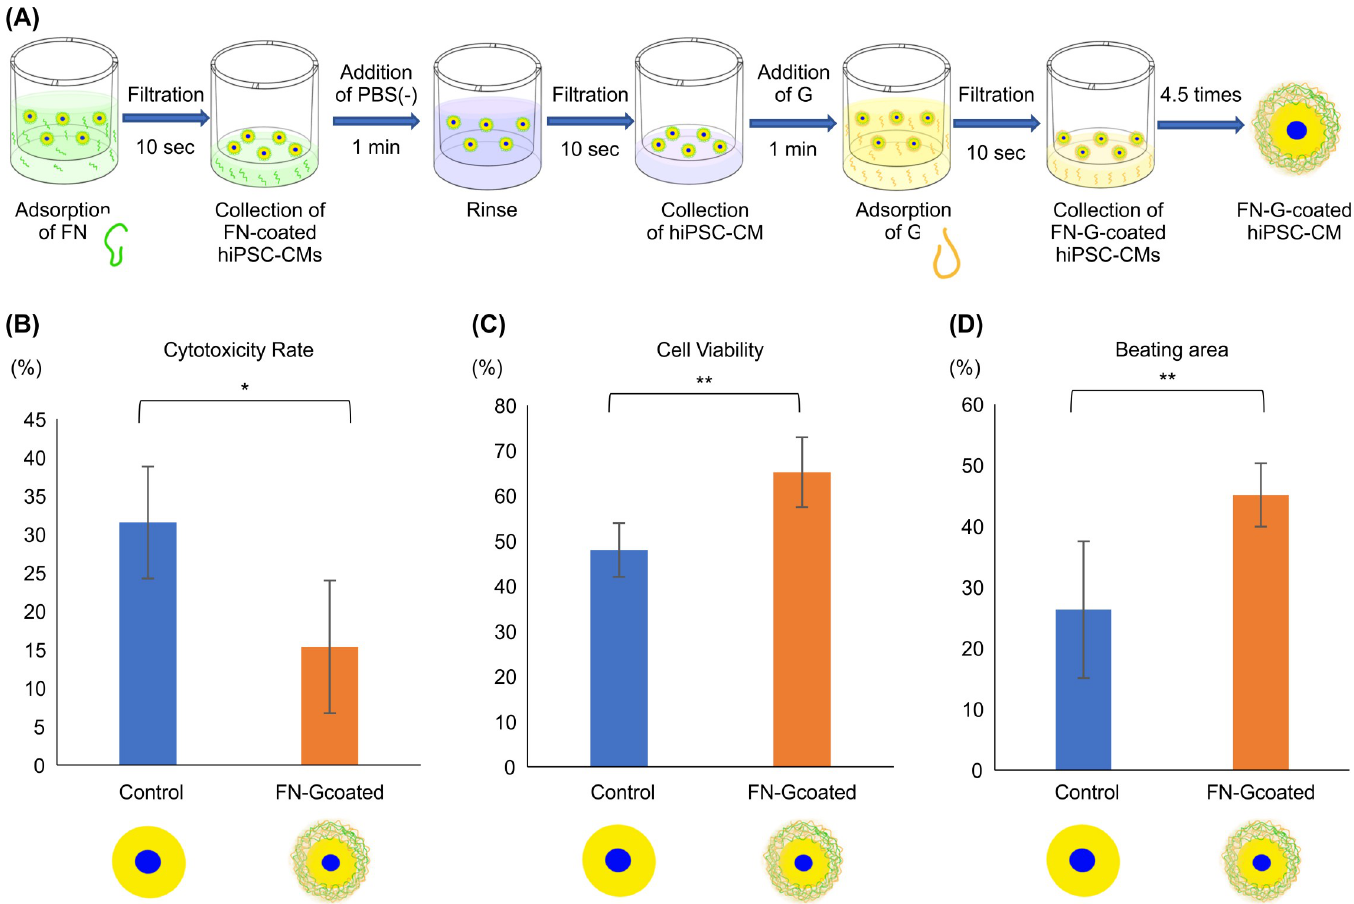
Fig 1. Fibronectin (FN)-gelatin (G)-coated human induced pluripotent stem cell-derived cardiomyocytes (hiPSC-CMs) had improved tolerance to hypoxia. (A) Schematic illustration of layer-by-layer filtration for nanofilm coating with FN and G on cell surfaces. (B) Lactate dehydrogenase production (LDH) assay. (C) Cell survival using Cell Counting Kit-8. (D) The beating area of cells assessed by Cell Motion Imaging System. � P < 0.01, �� P < 0.001.